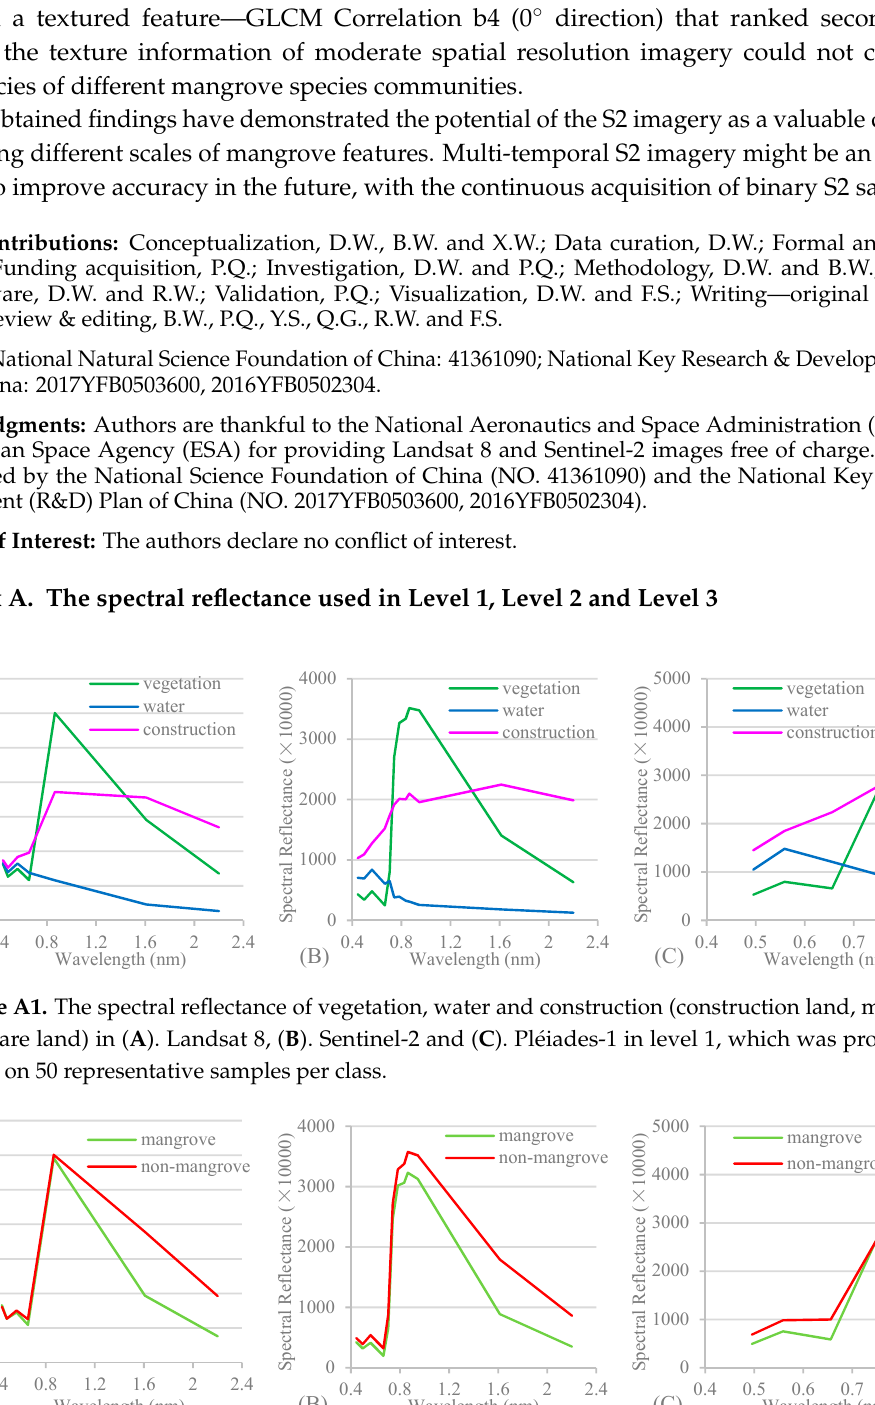
Figure A3. The spectral reflectance of six mangroves species in ( A ). Landsat 8, ( B ). Sentinel-2 and ( C ). Pléiades-1 in level 3. BS is B. sexangula, CT is C. tagal , RS is R. stylosa, KC is K. candel, AM is A. marina , and LR is L. racemos . References 1.